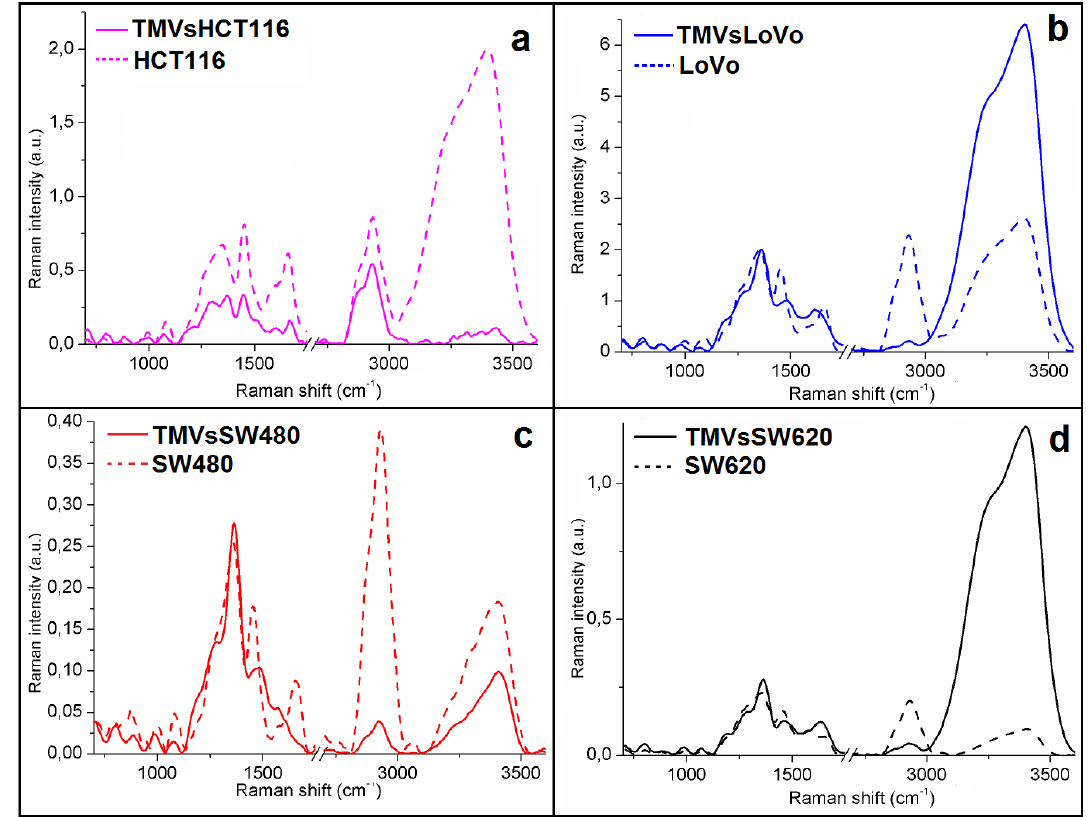
Figure 4. Raman spectra of: ( a ) HCT116; ( b ) LoVo; ( c ) SW480 and ( d ) SW620 cell lines (dashed lines) and of: ( a ) TMV HCT116 ; ( b ) TMV LoVo ; ( c ) TMV SW480 and ( d ) TMV SW620 (full lines).